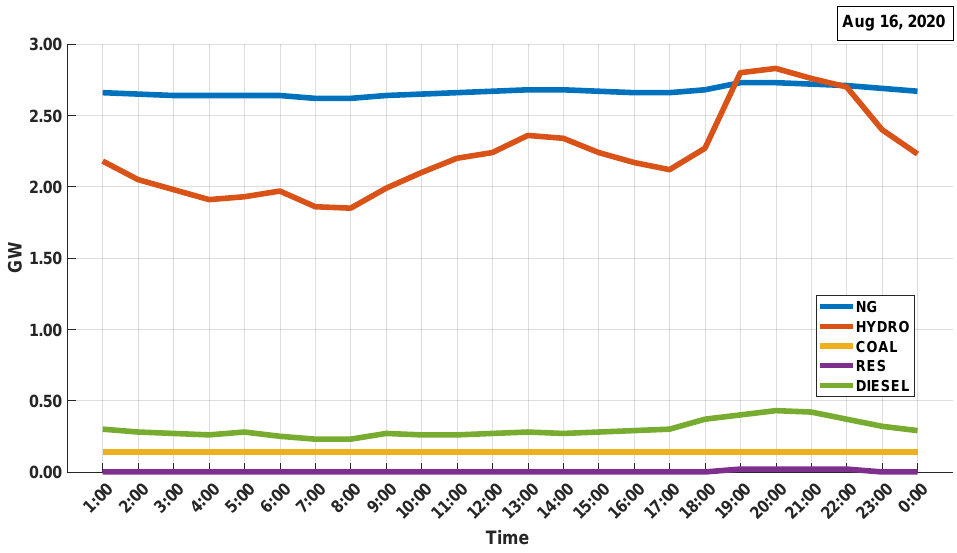
Figure 15. Contribution to demand by type of technology—stage 2.